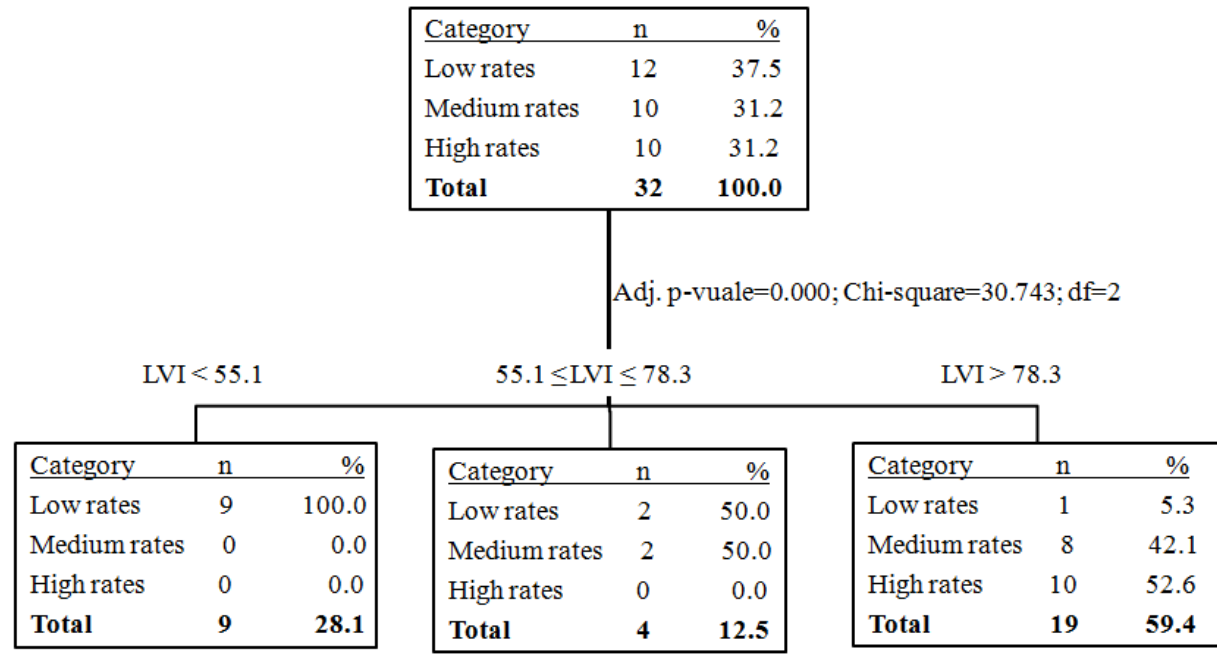
Figure 2. Classification tree according to the local vulnerability index